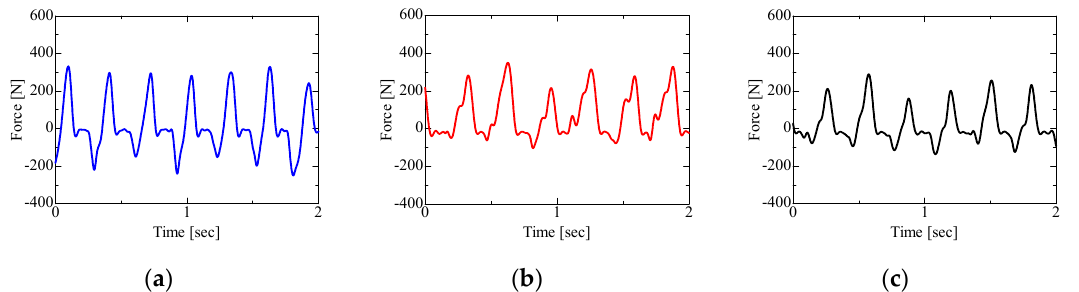
Figure 5. Results for propulsion force in running conditions: ( a ) low target load; ( b ) medium target load; ( c ) constant belt speed.